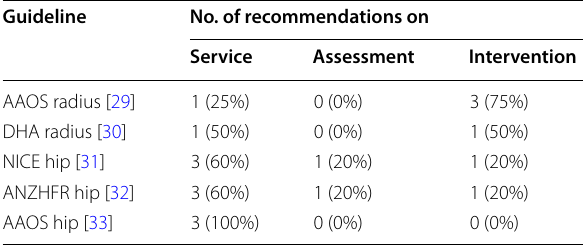
Table 2 Number of recommendations per type in each